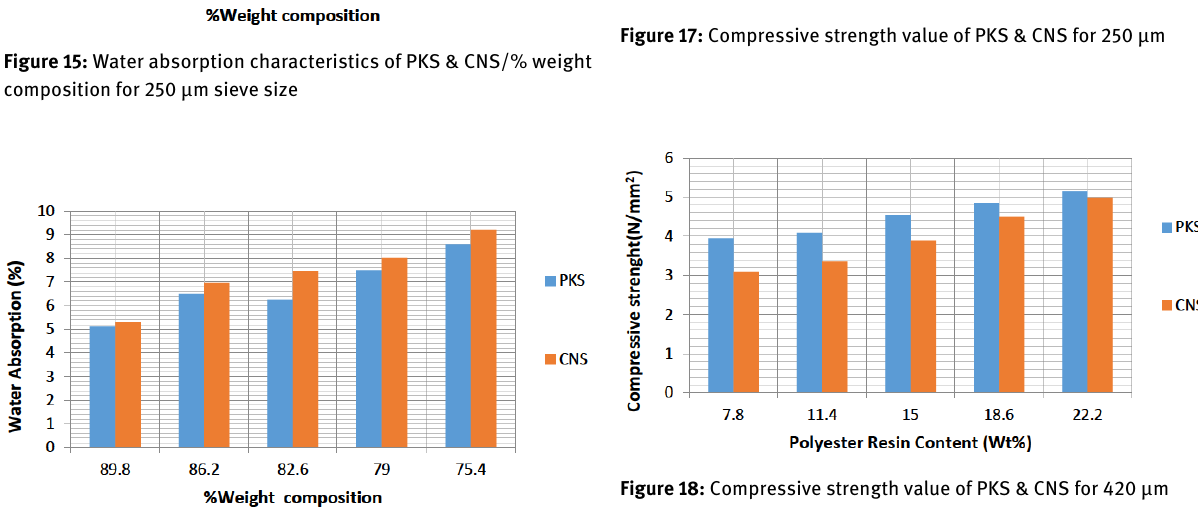
Figure 16: Water absorption characteristics of PKS & CNS/% weight composition for 420 µ m sieve size